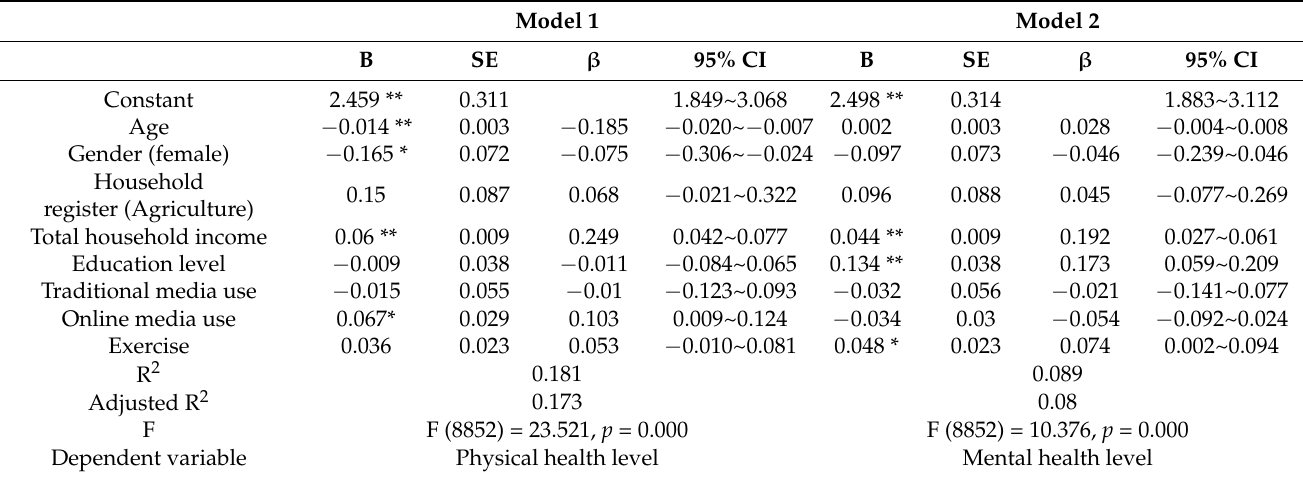
Table 7. Linear regression analysis